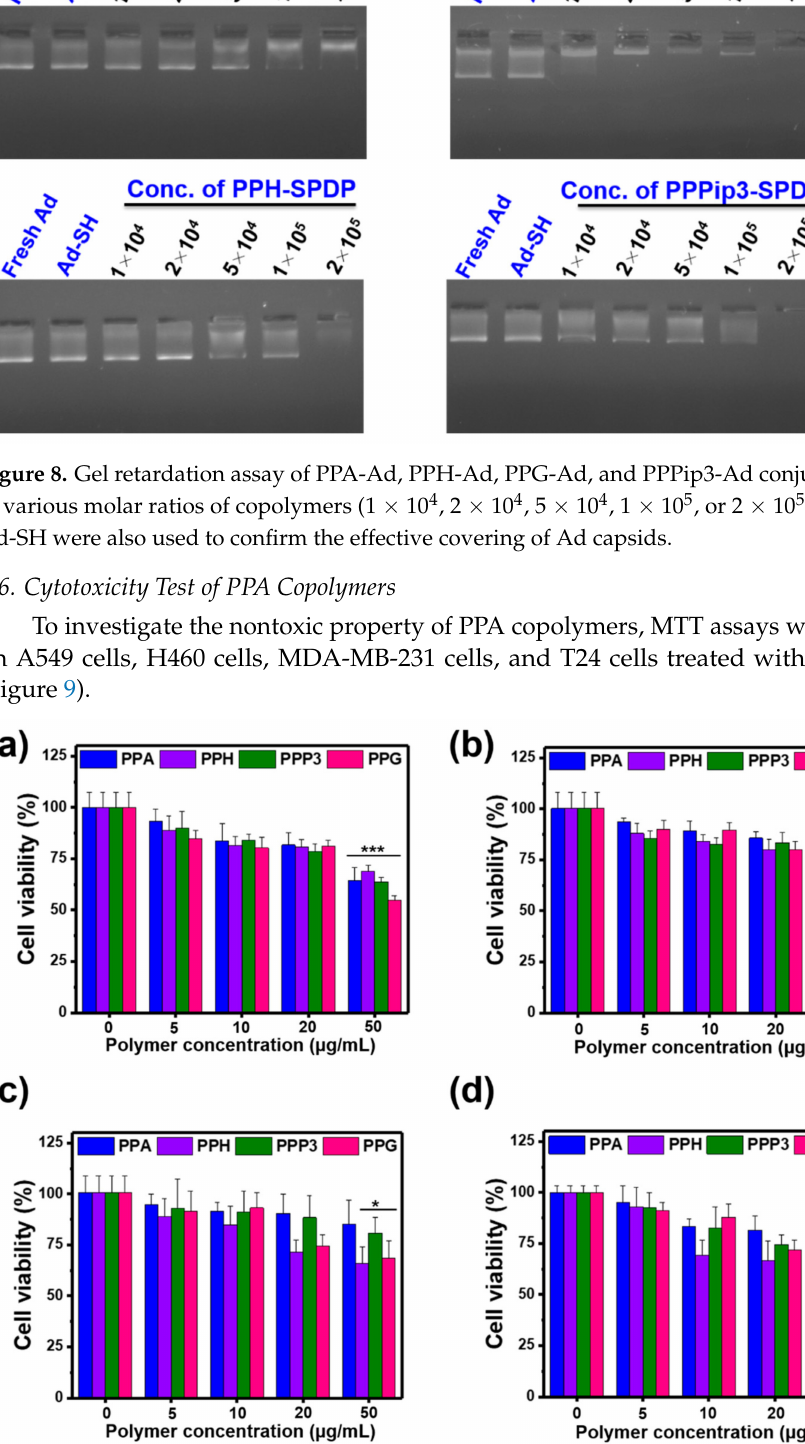
Figure 9. In vitro cell viability of PPA, PPH, PPG, and PPPip3 copolymers on ( a ) A549 cells, ( b ) H460 cells, ( c ) MDA-MB-231 cells, and ( d ) T24 cells. For measurement, cells were exposed to different concentrations of copolymer for 72 h, and the cells were subjected to MTT analysis. The error bars represent means ± SD ( n = 3). *** p < 0.001 and * p < 0.01 compared with control (0 µ